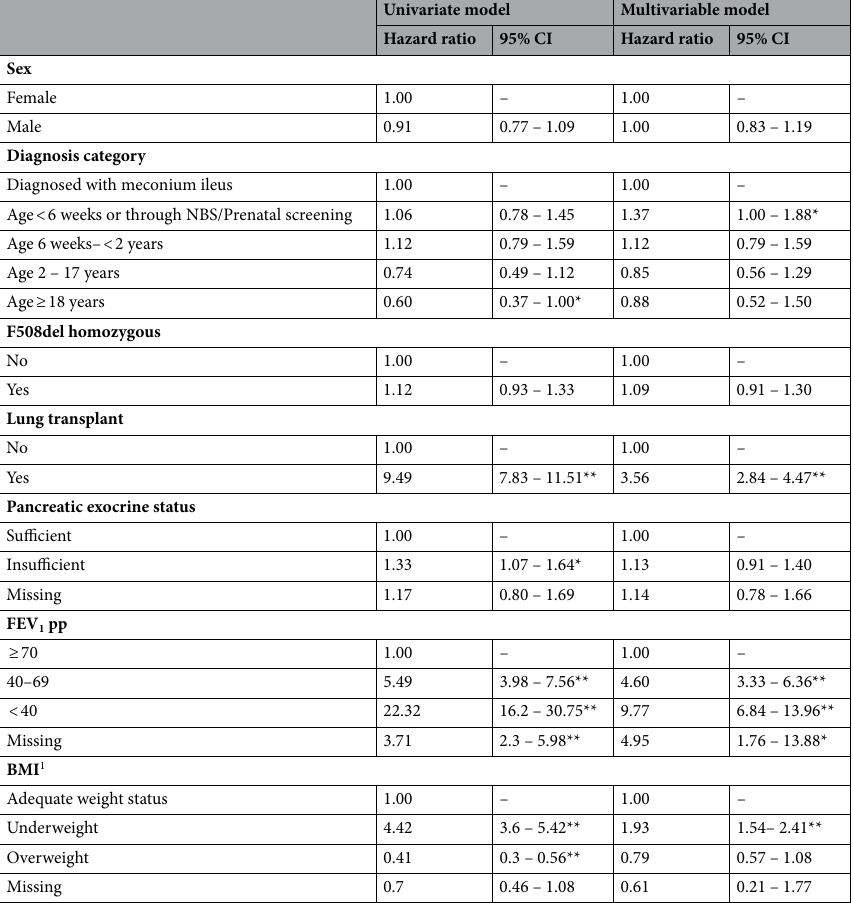
Table 2. Univariate and multivariable Cox proportional hazard models for death adjusted for demographic and clinical characteristics (2005–2020). BMI body mass index, FEV1pp percent predicted forced expiratory volume in one second. 1 Adult individuals (≥ 18 years) were classified into BMI categories based on World Health Organization guidelines as underweight (< 18.5 kg/m 2 ), adequate weight (18.5–24.9 kg/m 2 ), or overweight (≥ 25.0 kg/m 2 ). Children were classified as underweight (< 10th percentile), adequate weight (10- 85th percentile), or overweight (> 85th percentile). * p < 0.05. **p < 0.001.